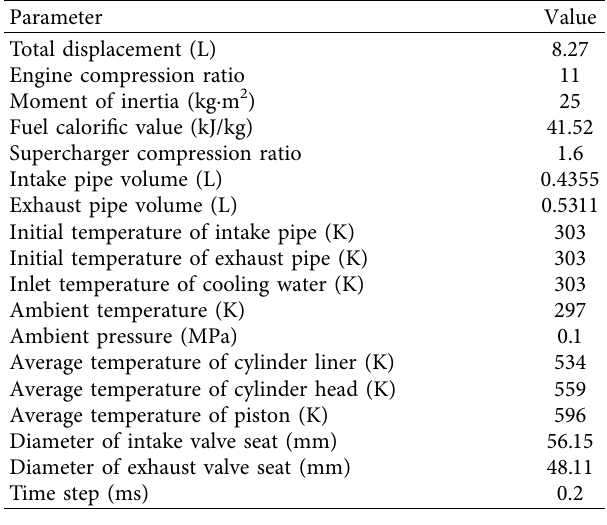
Table 3: Main parameters of the simulation model.